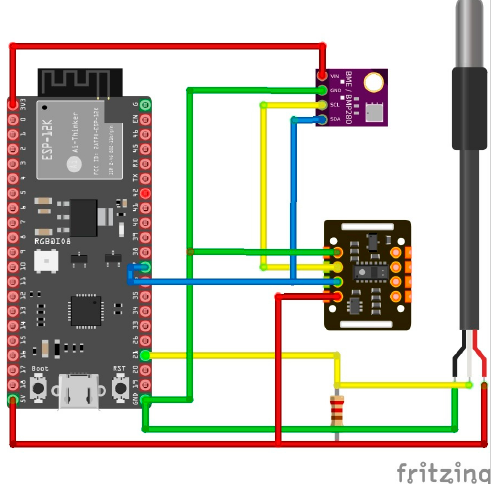
Figure 4. Circuit diagram of Health Monitoring System.